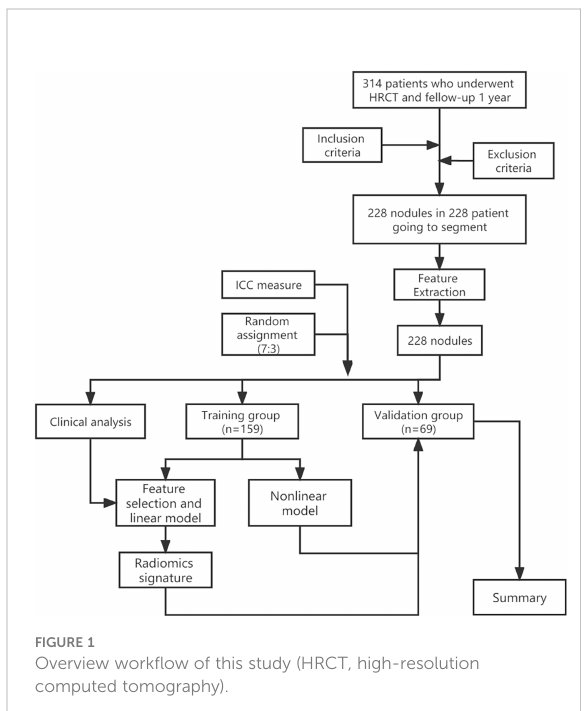
FIGURE 1 Overview work fl ow of this study (HRCT, high-resolution computed